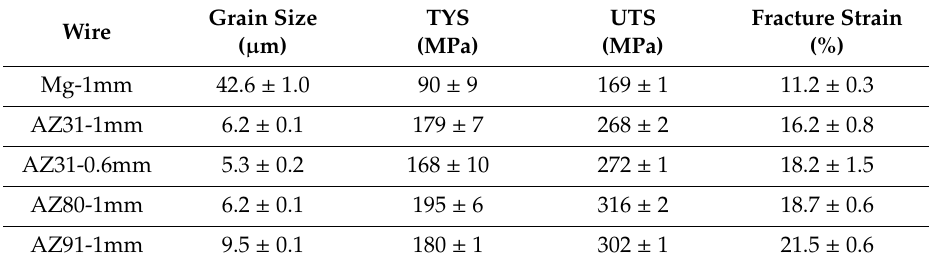
Table 3. Grain size calculated from the electron backscatter di ff raction (EBSD) measurement and mechanical properties from tension tests parallel to ED (tensile yield stress (TYS), ultimate tensile stress (UTS)) with standard